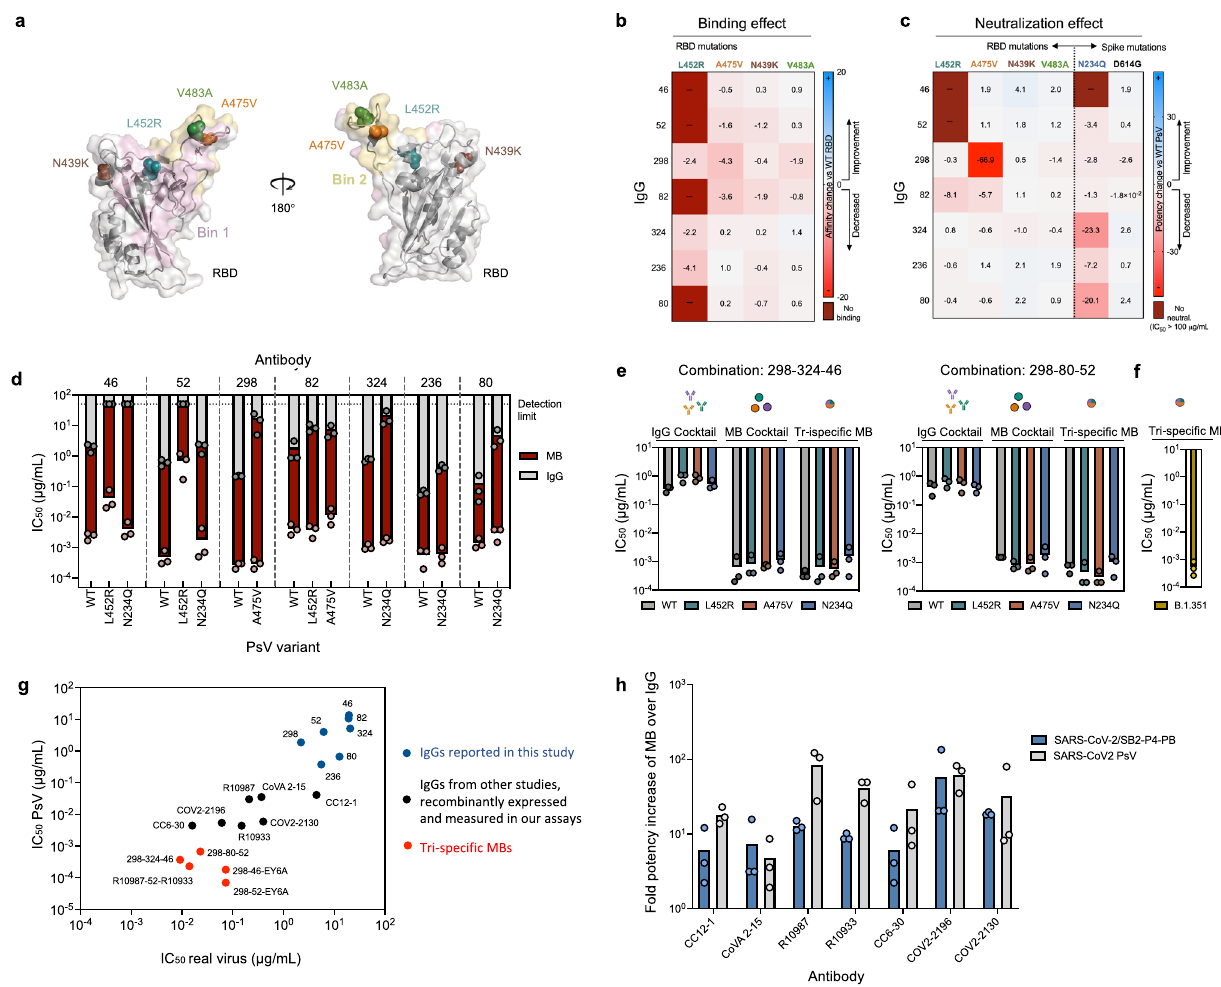
Fig. 6 Multabodies overcome SARS-CoV-2 sequence diversity. a Cartoon representation of the RBD showing four naturally occurring mutations as spheres. The epitopes of mAbs 52 (light pink) and 298 (yellow) are shown as representative epitopes of each bin. b Af fi nity and c IC 50 fold-change comparison between WT and mutated RBD and PsV, respectively. d Neutralization potency of IgG (gray bars) vs MB (dark red bars) against